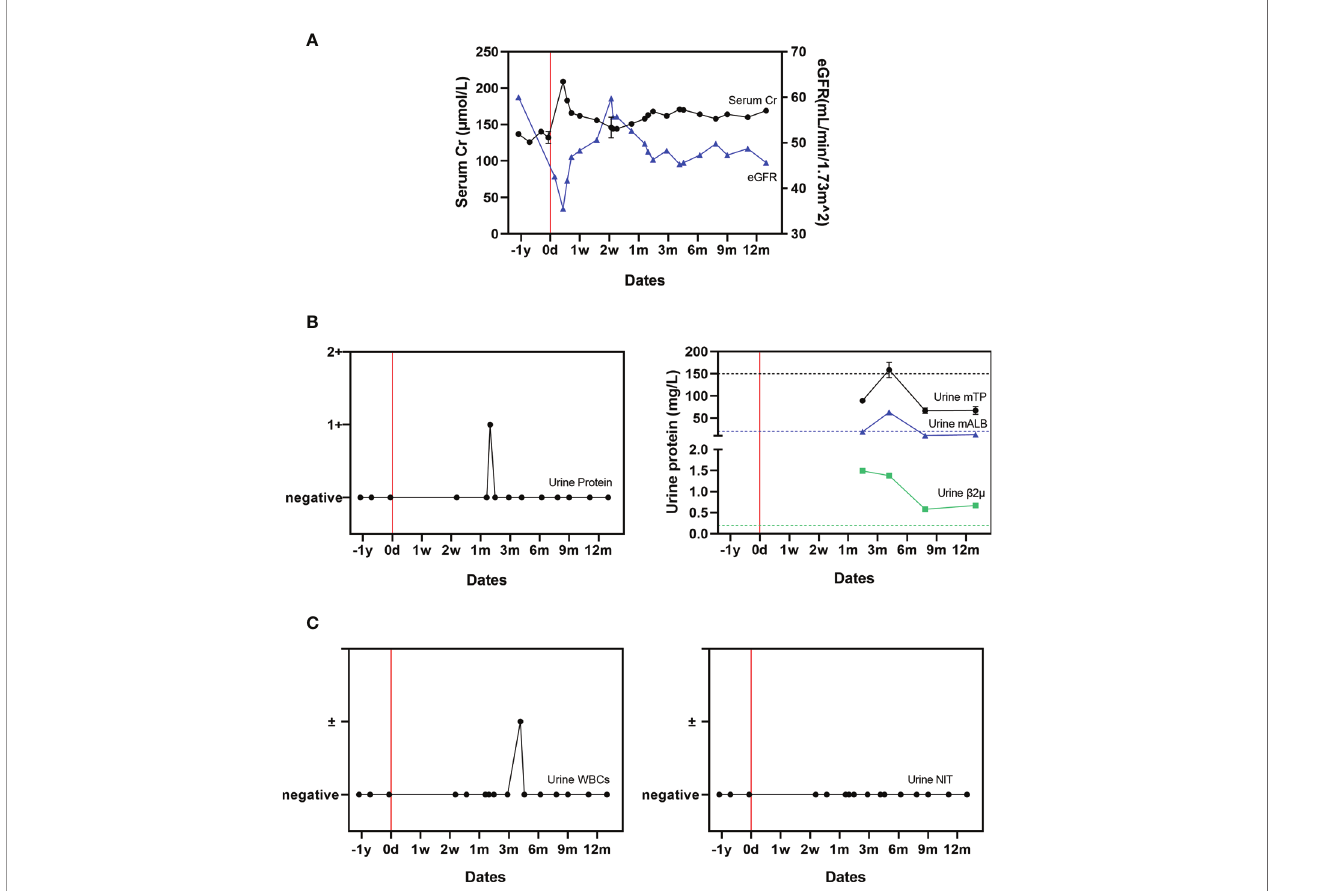
FIGURE 2 | Changes in renal function related to COVID-19. (A) Serial serum creatinine and eGFR measurements; (B) Urine protein, micro total protein, micro albumin, and b 2 microglobulin measurements. (C) Urinary WBCs and urinary nitrite (NIT) measurements. The mean value derived from two uninfected paired controls is shown using dotted lines as a